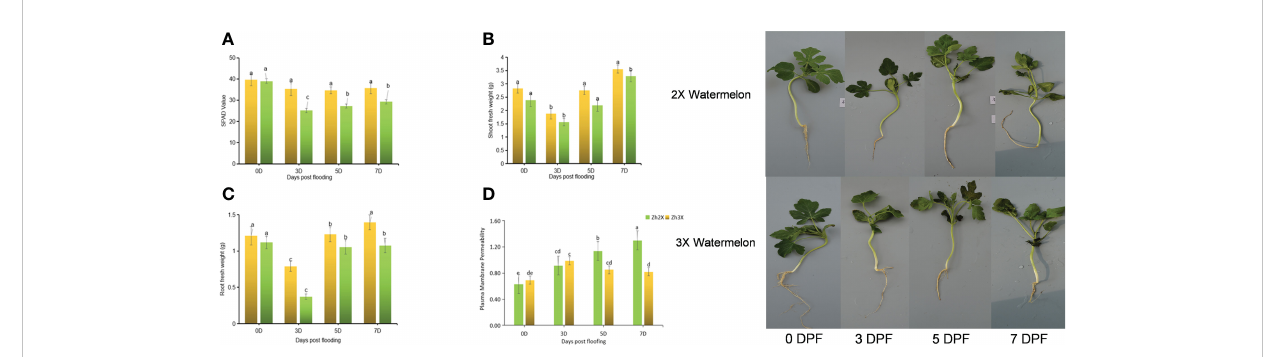
FIGURE 1 Fluctuations in Chlorophyll Content as well as other Growth indices. (A) SPAD values. (B) Shoot FW. (C) Root FW. (D) Plasma membrane permeability. Perpendicular bars display averages ± SD (n = 6). Lower case letters above each bar present signi fi cant changes at p < 0.05 (Duncan ’ s multiple range test). DPF stands for days post fl